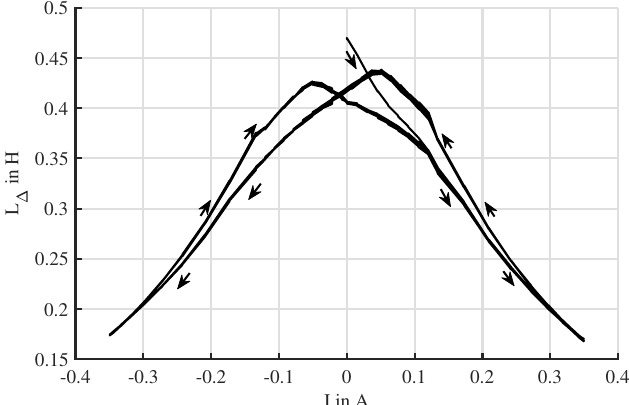
Figure 13. Experimentally-identified incremental inductance, which shows the typical butterfly